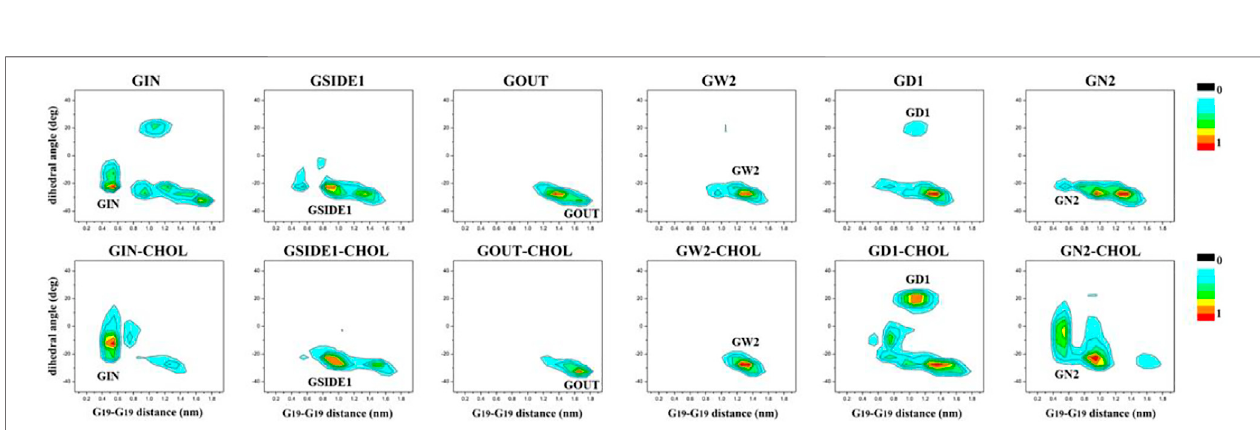
FIGURE3|(A) COMdistancebetweenC99monomersasafunctionoftime. (B) COMdistancebetweenthetwospeci fi edresiduesG19andG19 ′ asafunctionof time. (C) Conformation distributions for C99 homodimer were projected onto the two parameters of Ω and G − G. Ω is the interhelix dihedral angle of C99 dimer; G − G is the distance between G19 and G19 ′ . The data are from the simulations initiated with GIN conformation with (bottom) or without cholesterol (top). The colored scale on the right de fi nes the relative population.